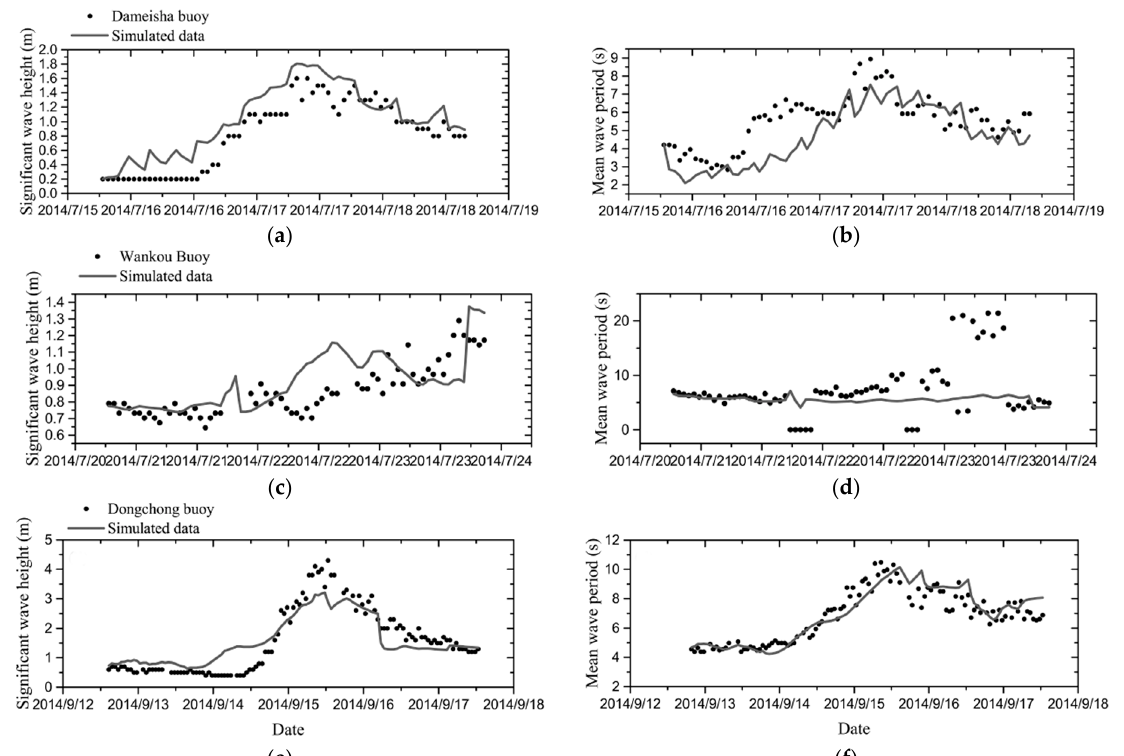
Figure 2. Comparisons between observed and simulated H s and T 01 15–18 July, 20–24 July and 12–18 September in 2014: ( a ) H s in Typhoon Rammasun; ( b ) T 01 in Typhoon Rammasun; ( c ) H s in Typhoon Matmo; ( d ) T 01 in Typhoon Matmo; ( e ) H s in Typhoon Kalmaegi; and ( f ) T 01 in Typhoon